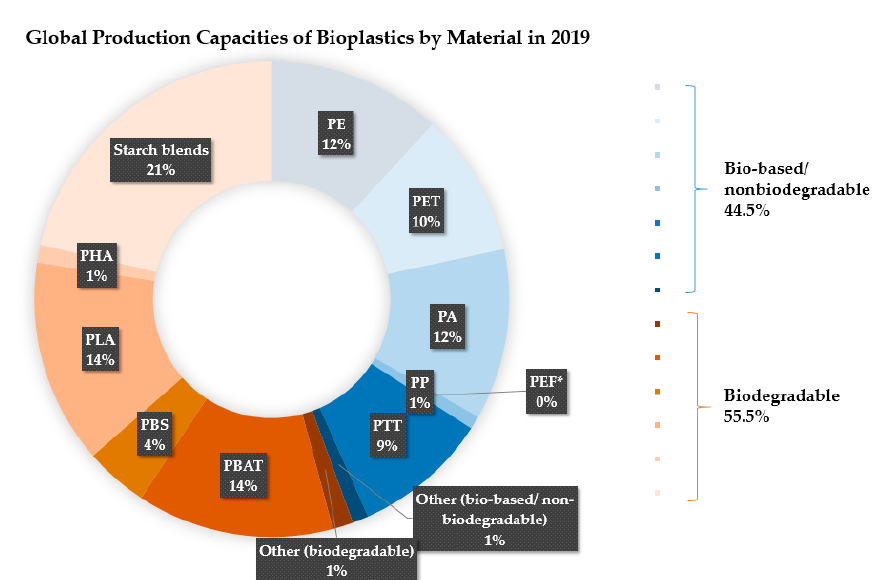
Figure 1. Types of bioplastics [4].